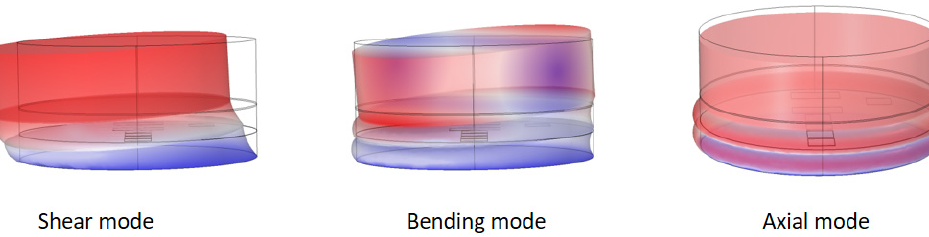
Figure 7. The three modes of the rubber cylinder computed by FE model.